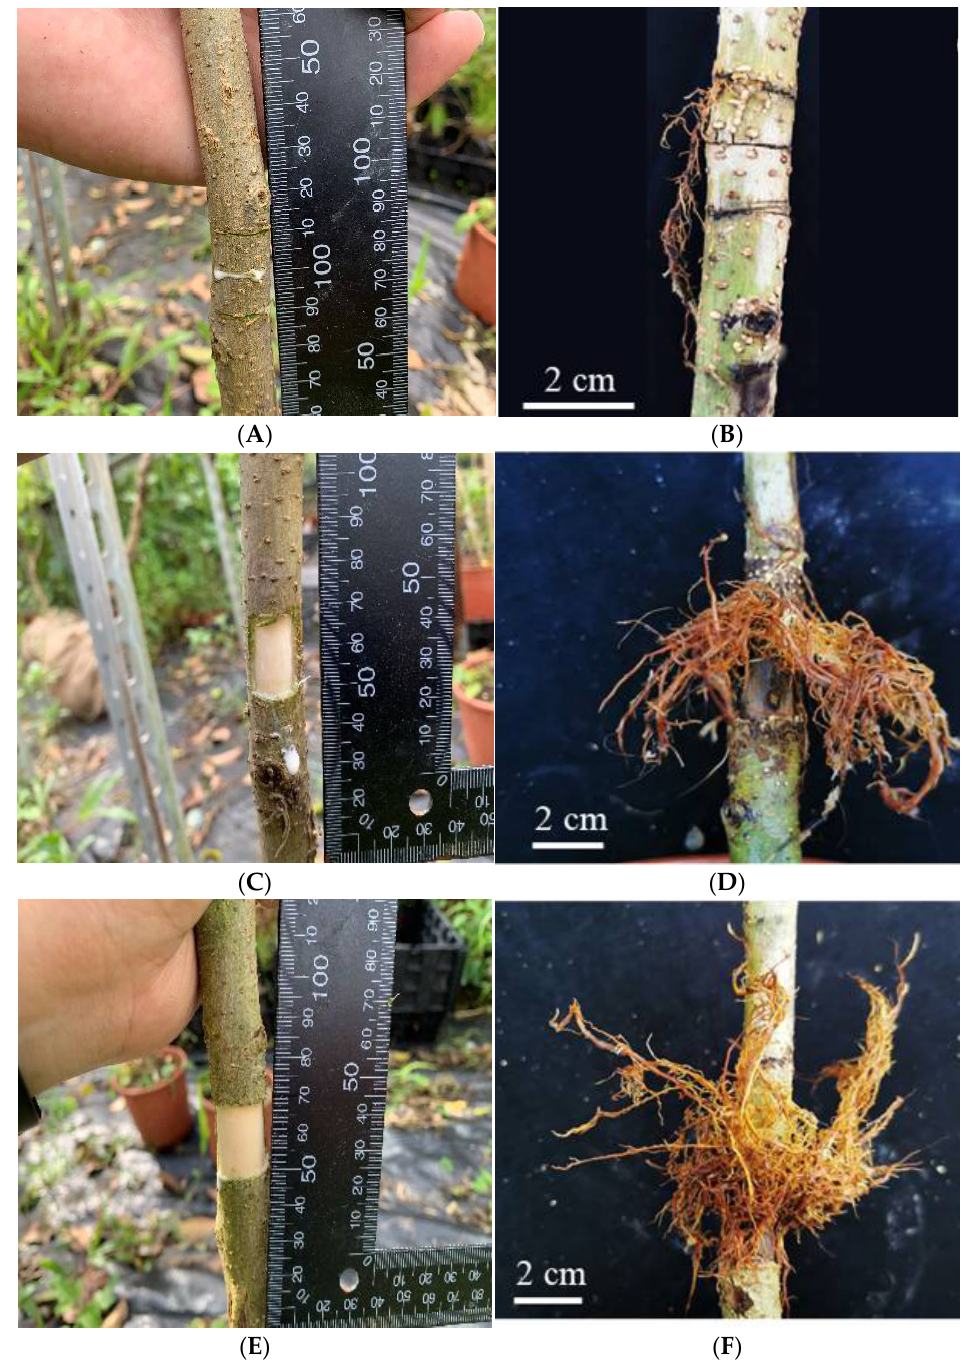
Figure 1. Wounding methods to regenerate ARs on the stems of F. benjamina . ( A ) Three-line cut on the stem (3LC); ( B ) ARs on the 3LC wound; ( C ) rectangular peel with 1/3 of the stem perimeter (RP13); ( D ) ARs on the RP13 wound; ( E ) rectangular peel with 2/3 of the stem perimeter (RP23); and ( F ) ARs on the RP23 wound.